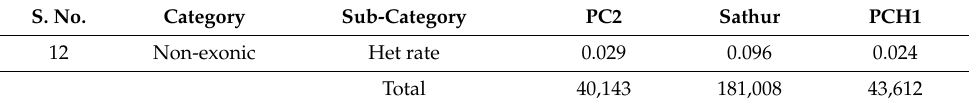
Upstream: SNPs located within 1 kb upstream (away from transcription start site) of the gene. Exonic: SNPs located in exonic region; non-synonymous: single nucleotide mutation with changing amino acid sequence; stop gain/loss: a nonsynonymous SNP that leads to the introduction/removal of stop codon at the variant site; synonymous: single nucleotide mutation without changing amino acid sequence. Intronic: SNPs located in intronic region. Splicing: SNPs located in the splicing site (2 bp range of the intron/exon boundary). Down- stream: SNPs located within 1 kb downstream (away from transcription termination site) of the gene region. Upstream/downstream: SNPs located within the <2 kb intergenic region, which is in 1 kb downstream or up- stream of the genes. Intergenic: SNPs located within the >2 kb intergenic region. ts: transitions, a point mutation